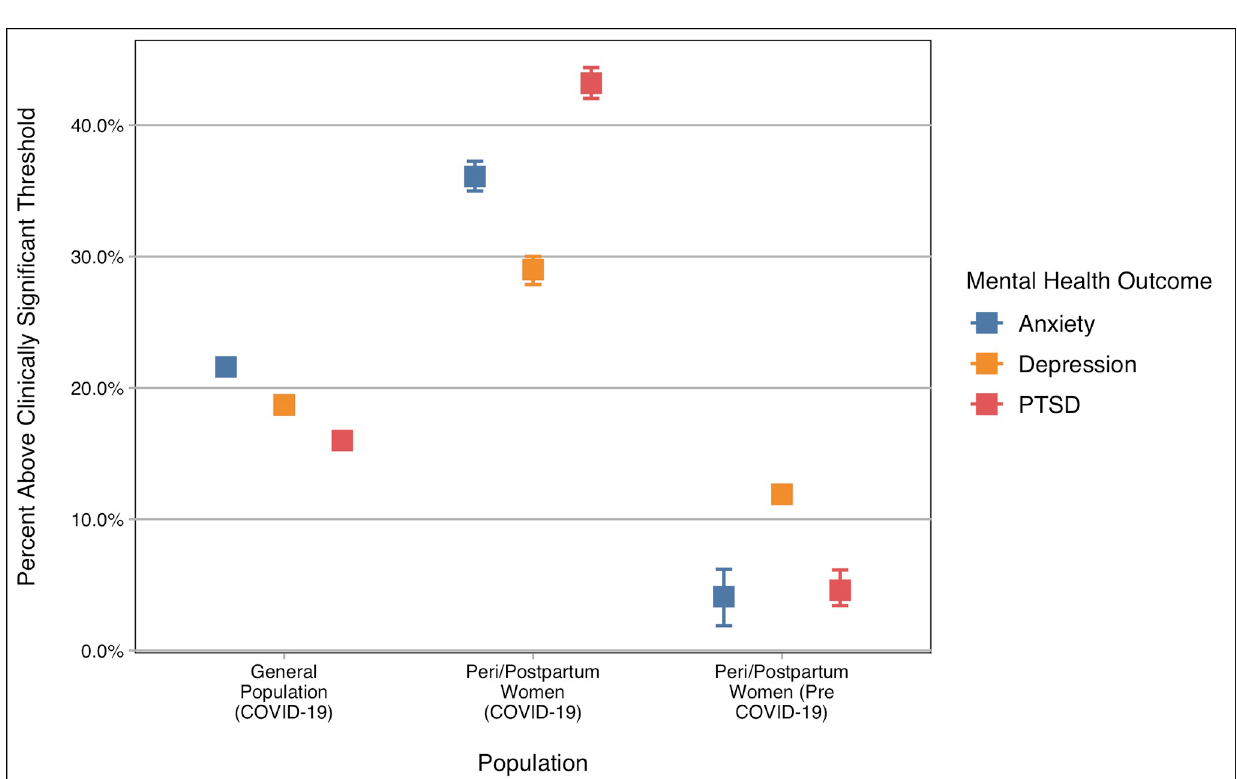
Fig 2. Comparison of anxiety, depression and posttraumatic stress prevalence between the general population and peri/postpartum women during the COVID-19 pandemic, and peri/postpartum women prior to the